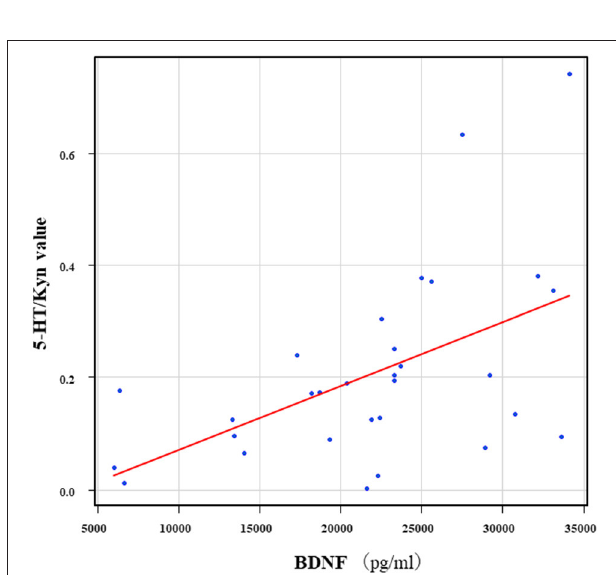
PANSS-T score and the QA/Kyn value ( r = − 0.50, p = 0.017, Figure 11 ).